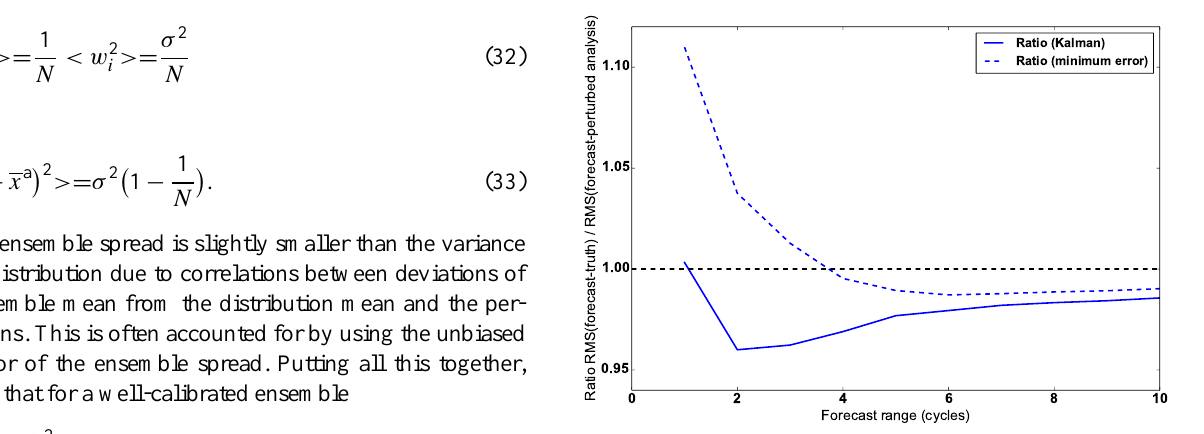
Figure 5. Ratio of the RMS errors of forecasts verified against truth and perturbed analyses using the logistic map for various lead times. For the solid line the background error was taken as the approximate Kalman value. For the dashed line B was taken for the value which minimises the short-period forecast